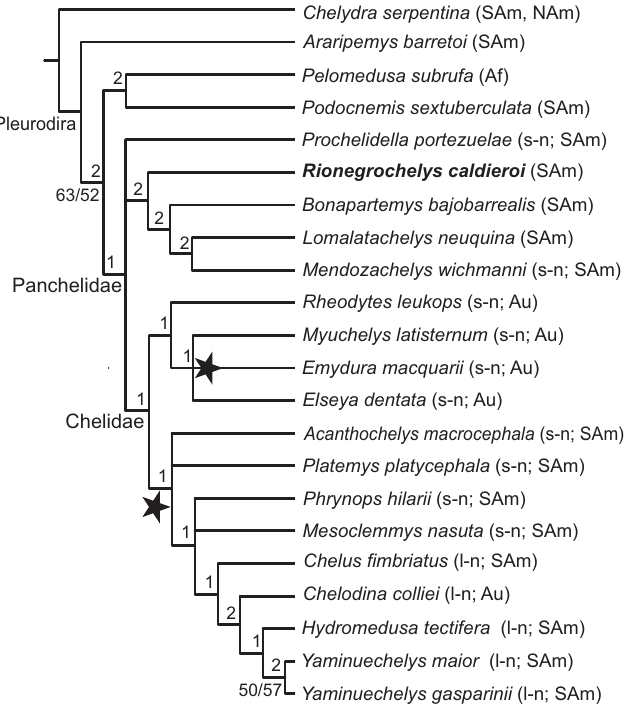
Fig. 9. Strict consensus tree from the four MPT’s obtained from the morphological cladistic analysis of Rionegrochelys caldieroi gen. et sp. nov. The stars show the alternative positions of Pseudemydura umbrina . The numbers in the left of the lines are Bremer support values, whereas the numbers in the right of the lines are Jackknife and Bootstrap support val- ues, respectively, that exceed 50%. Abbreviations: Af, Africa, SAm, South America, NAm, North America, Au, Australia; l-n, long-necked panche- lids, s-n, short-necked